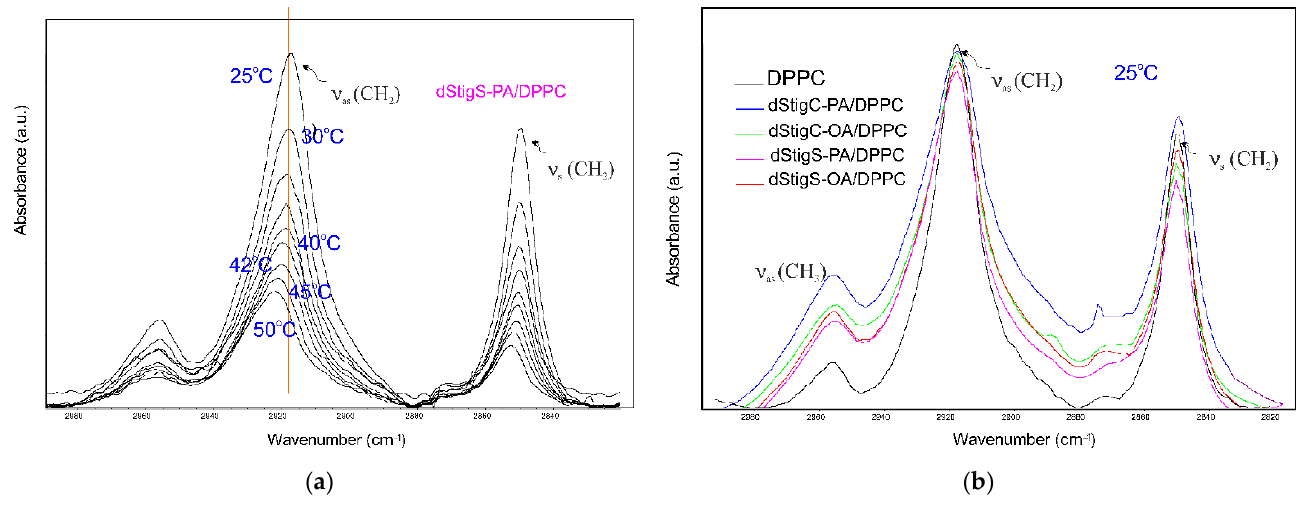
Figure 9. Infrared spectra of hydrated dStigS-PA/DPPC bilayer in the hydrocarbon chains region at different temperatures ( a ) and comparison of the spectra from the hydrophobic region of the bilayer of all tested compounds at the same temperature, in the gel phase ( b ); n dStigMAs /n DPPC = 0.20.